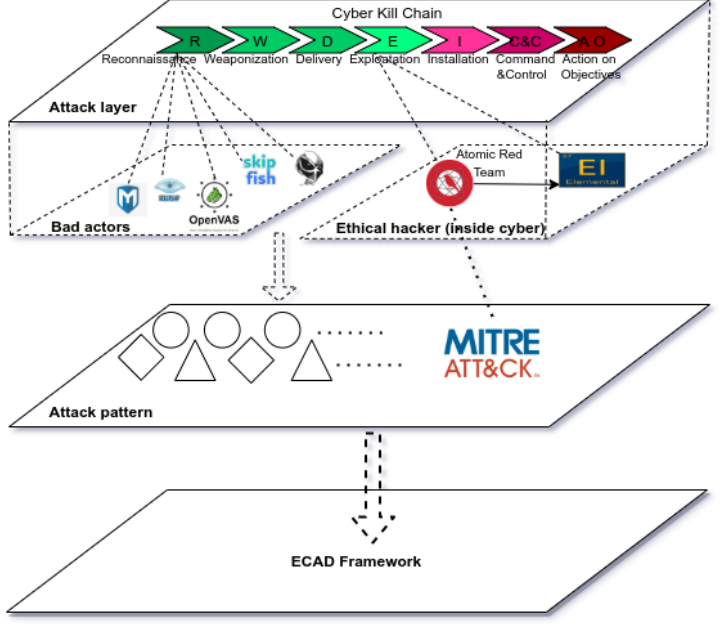
Figure 1. The operating context of the testing platform for the ECAD